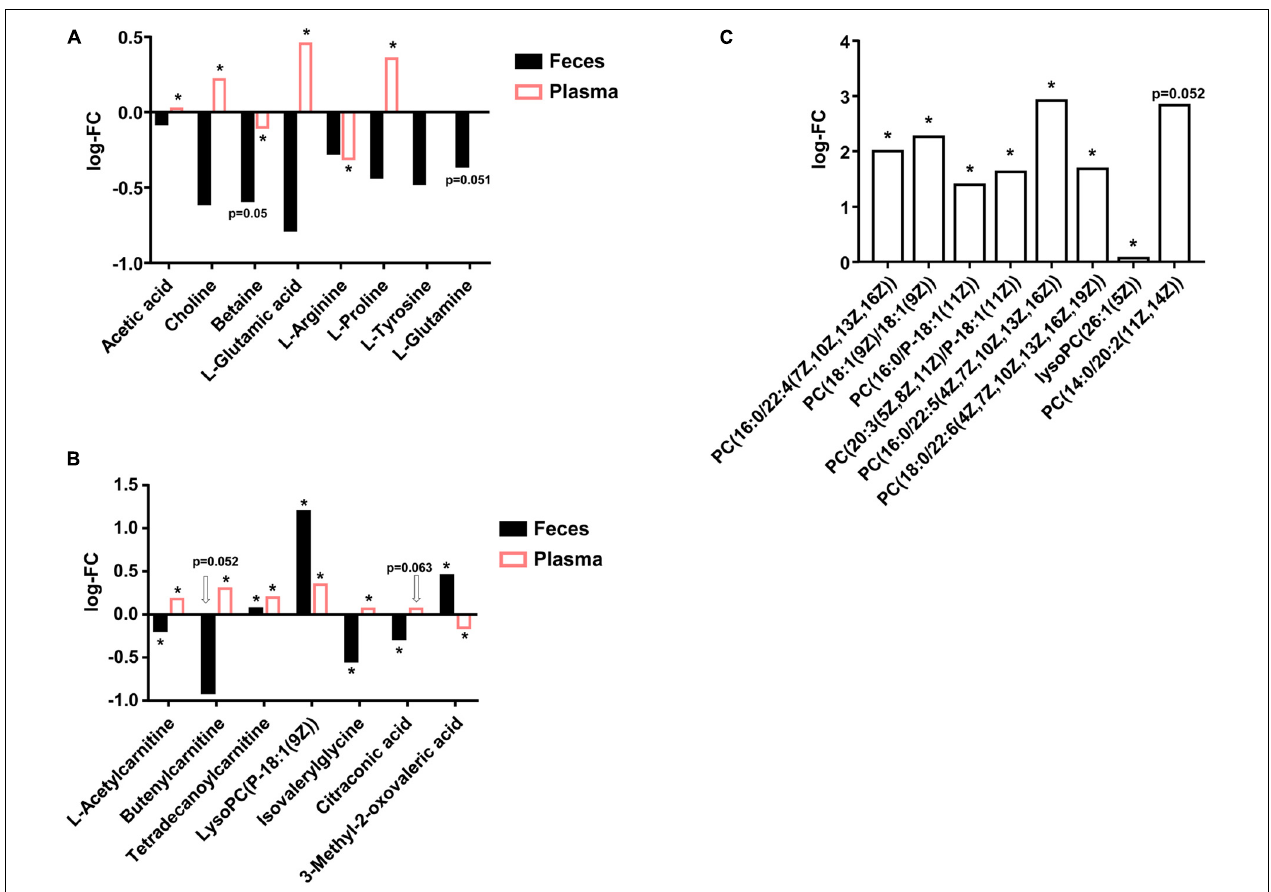
FIGURE 3 | Liquid chromatography–mass spectrometry (LC-MS) detected metabolites differences in fecal and plasma samples between healthy control and primary hypertension patients. (A) Actual changes of short-chain fatty acid (SCFA), trimethylamine (TMA) precursors, and amino acids in fecal and plasma samples predicted by metagenomic analysis. (B) Metabolites were significantly changed in both fecal and plasma samples. (C) Phosphocholines were significantly higher in hypertension (HBP) fecal samples. FC, fold change of HBP group to Ctrl group. PC, phosphocholines. p -values were evaluated by two-tailed Welch’s t -test based on compounds’ peak intensities. * p <